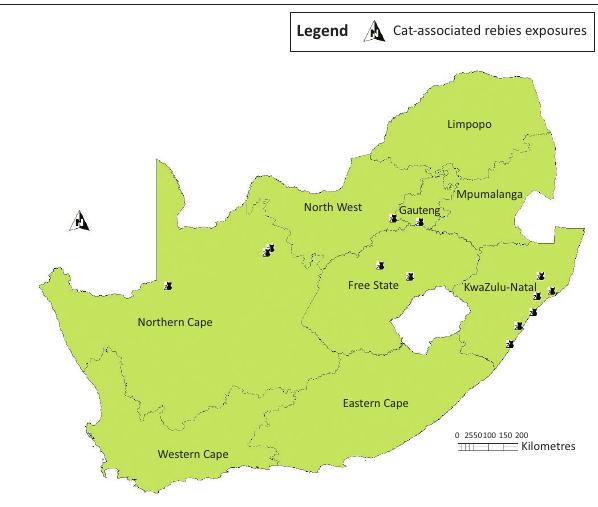
FIGURE 1: Location of confirmed human rabies cases associated with cat exposures in South Africa,